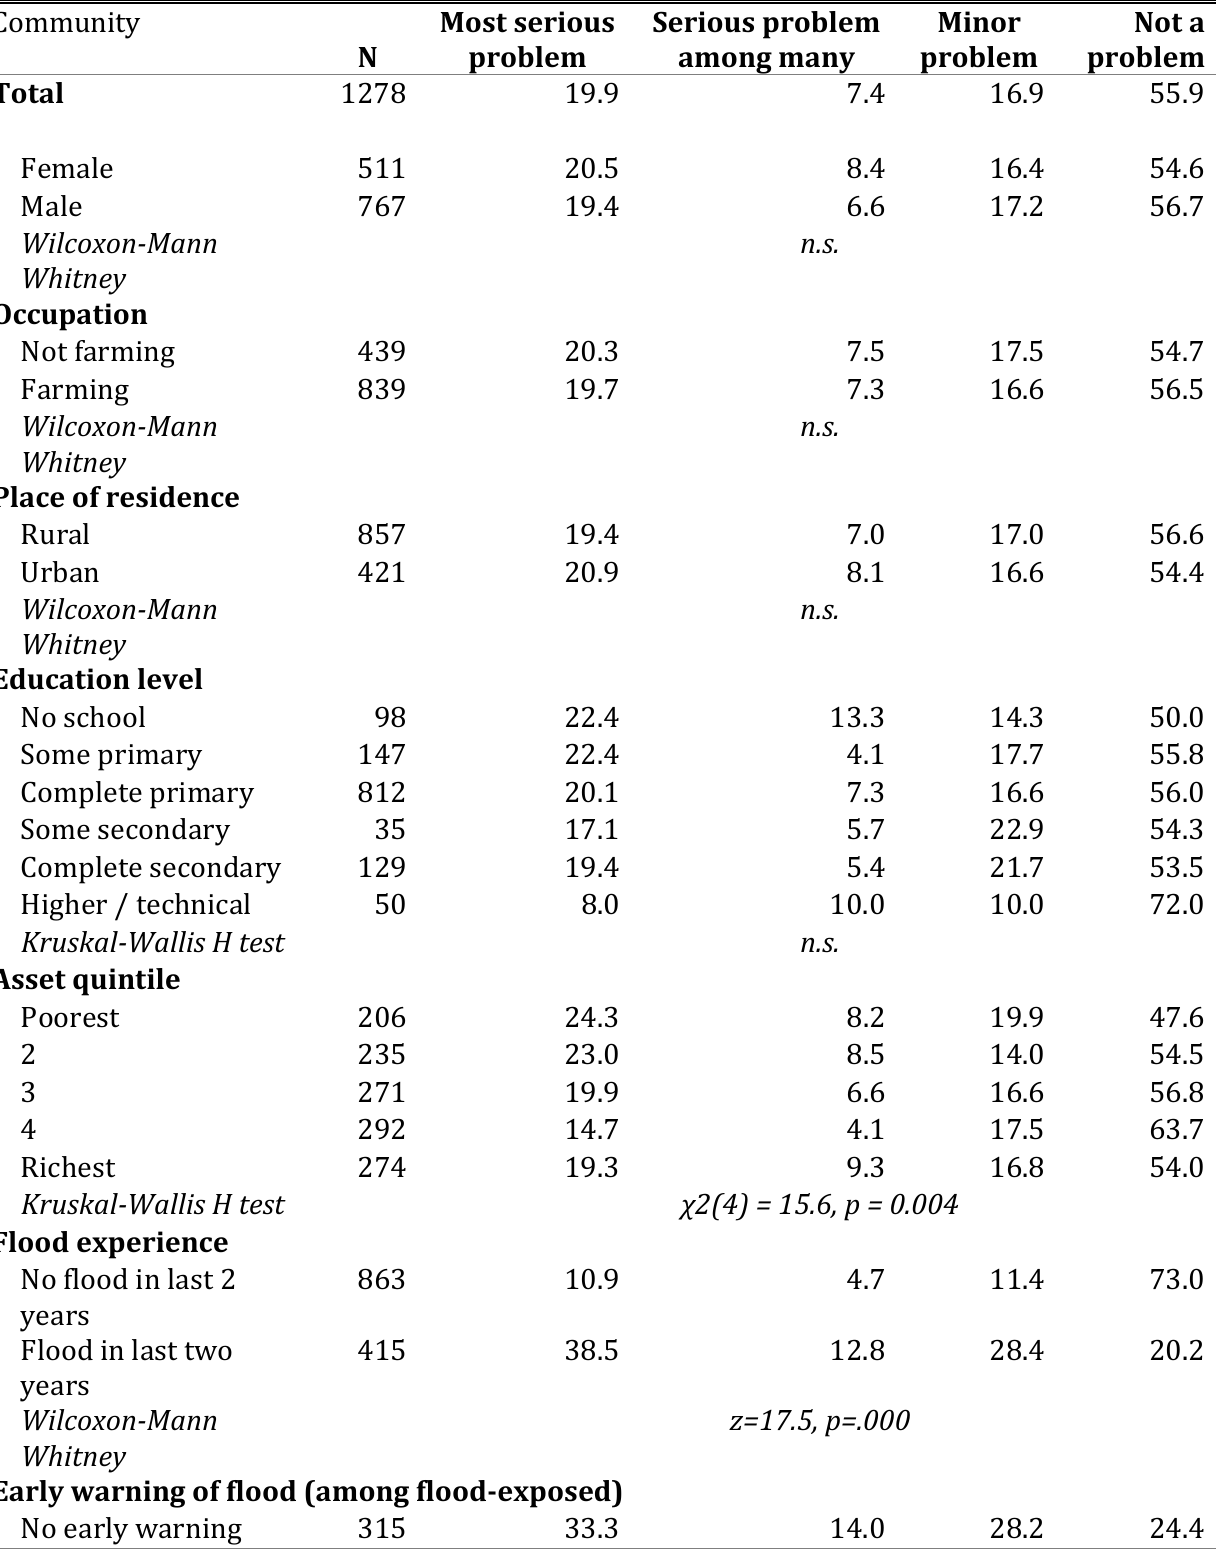
Table A1.3. Respondents’ perceptions of flood severity for their communities.